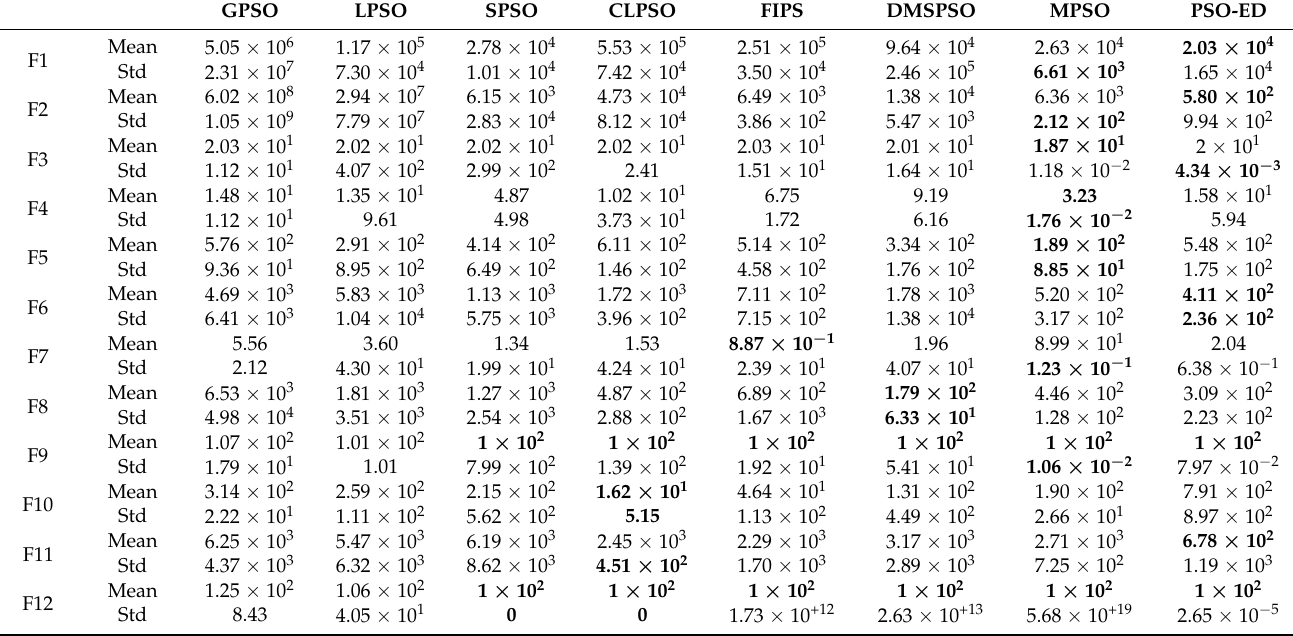
Table 6. Comparison of PSO-ED with 7 popular PSO variants for 10- D case.